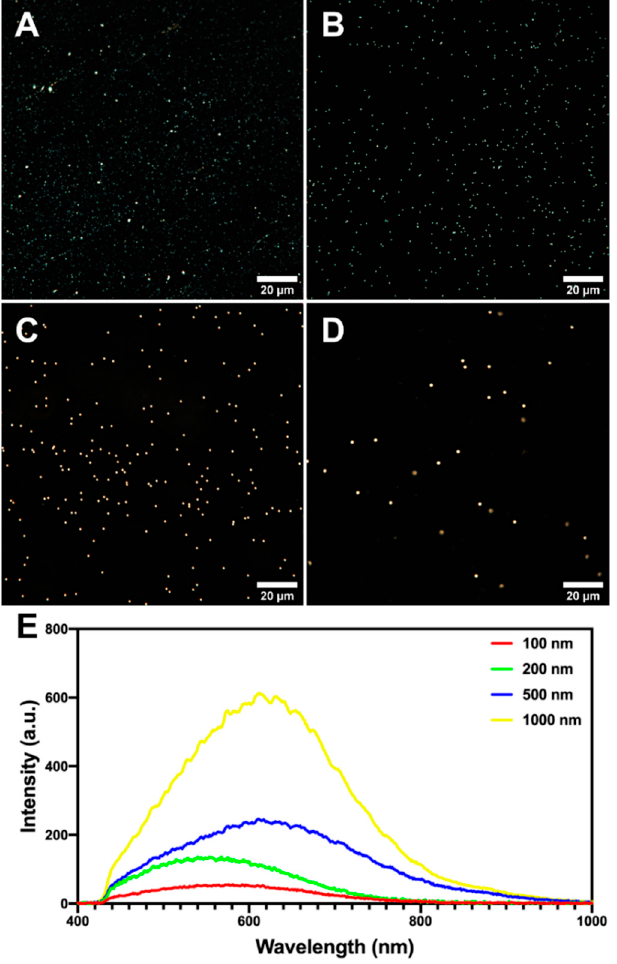
Figure 2. Dark-field images of ( A ) 100, ( B ) 200, ( C ) 500, ( D ) 1000 nm polystyrene particles in aqueous solution and ( E ) corresponding reflected/scattered Vis-near IR light spectra, obtained from hyperspectral images.